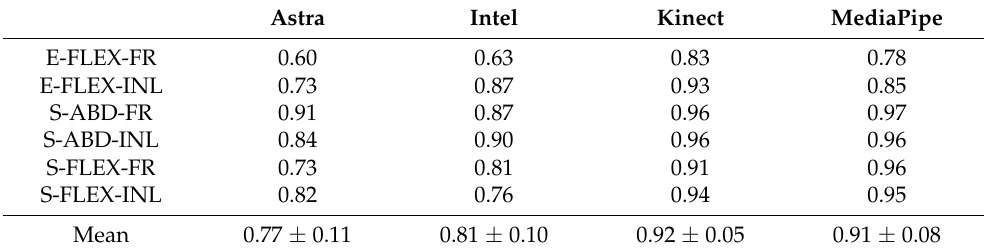
Table 12. Pearson correlation of the sensors for each upper limbs movement. Astra Intel Kinect